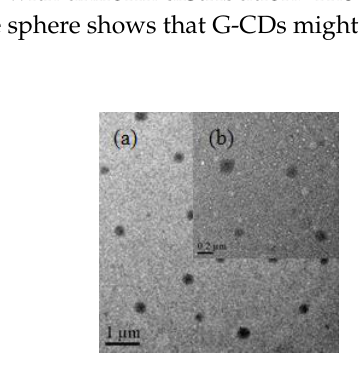
Figure 6. The TEM images of CDs/PNIPAM. ( a ) Overall view; ( b ) Enlarged view.